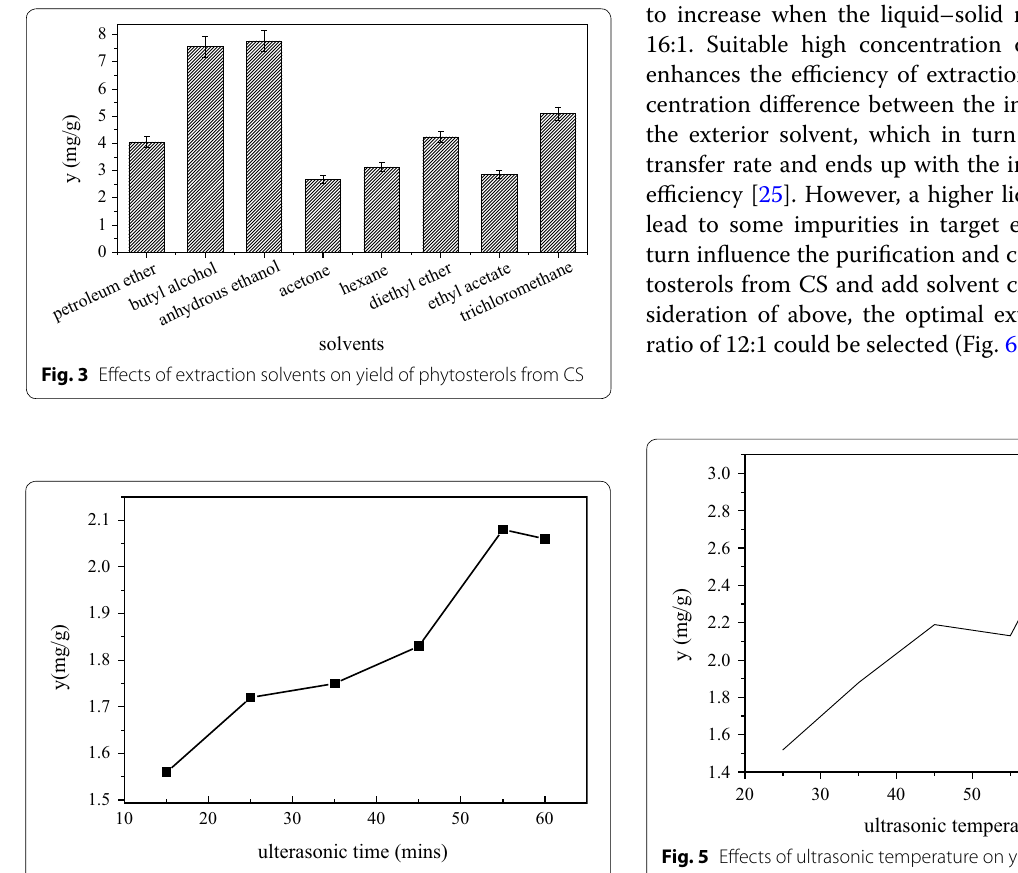
Fig. 4 Effects of ultrasonic time on yield of phytosterols from CS